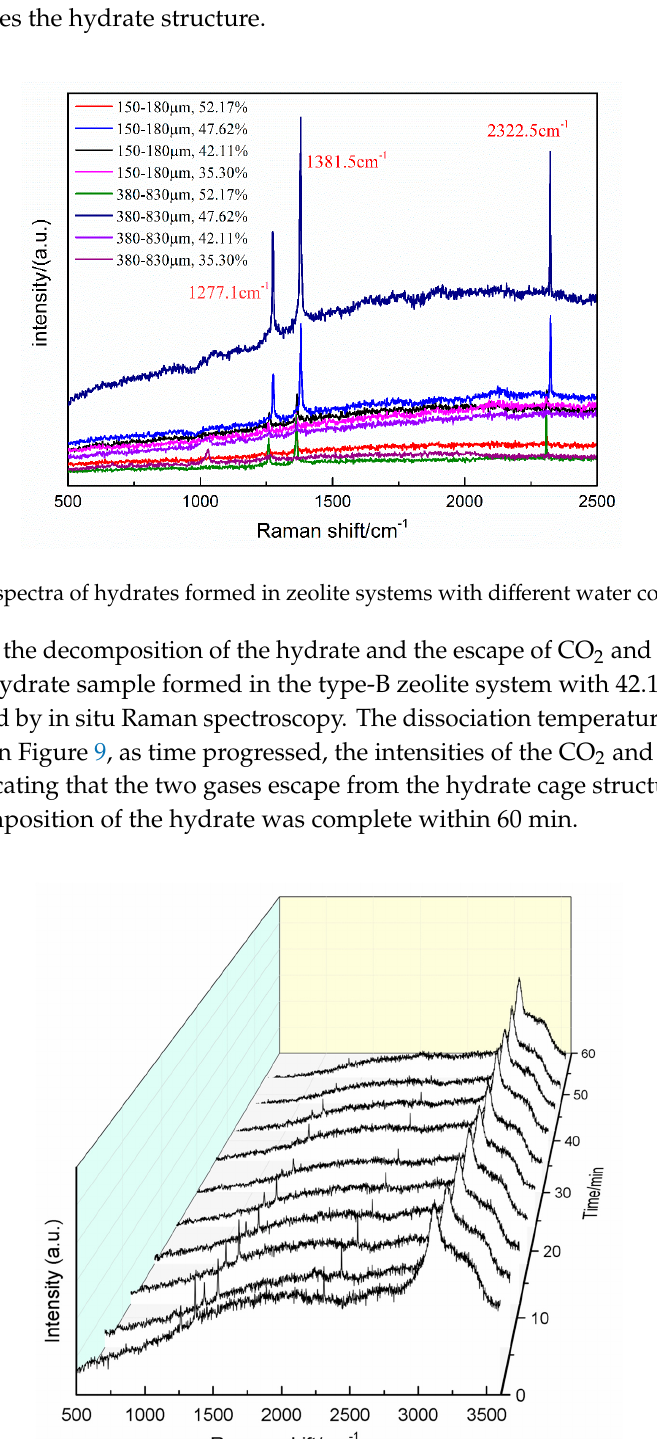
Figure 9. In situ Raman spectra during hydrate decomposition.